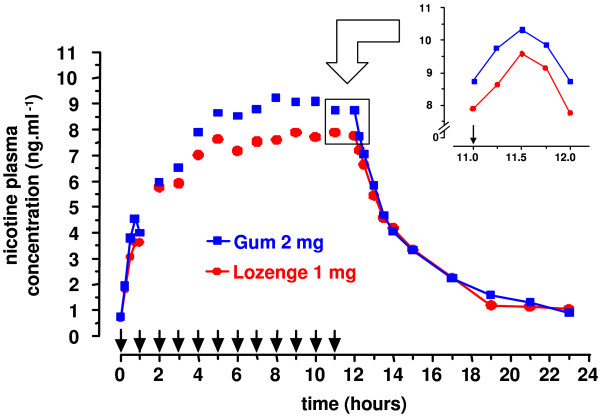
Nicotine plasma concentration after repeated intake (24 subjects). Nicotine plasma concentrations were determined in this multiple-dose bioequivalence trial with 24 volunteers from blood samples drawn before administration of each single dose (unconnected data points). Consecutive blood samples (connected data points) were drawn after administration of dose 1 (t = 0) and dose 12 (t = 11 h). The insert shows a blood nicotine peak after dosing at steady state obtained with blood draws after dose 12 (11–12 h).